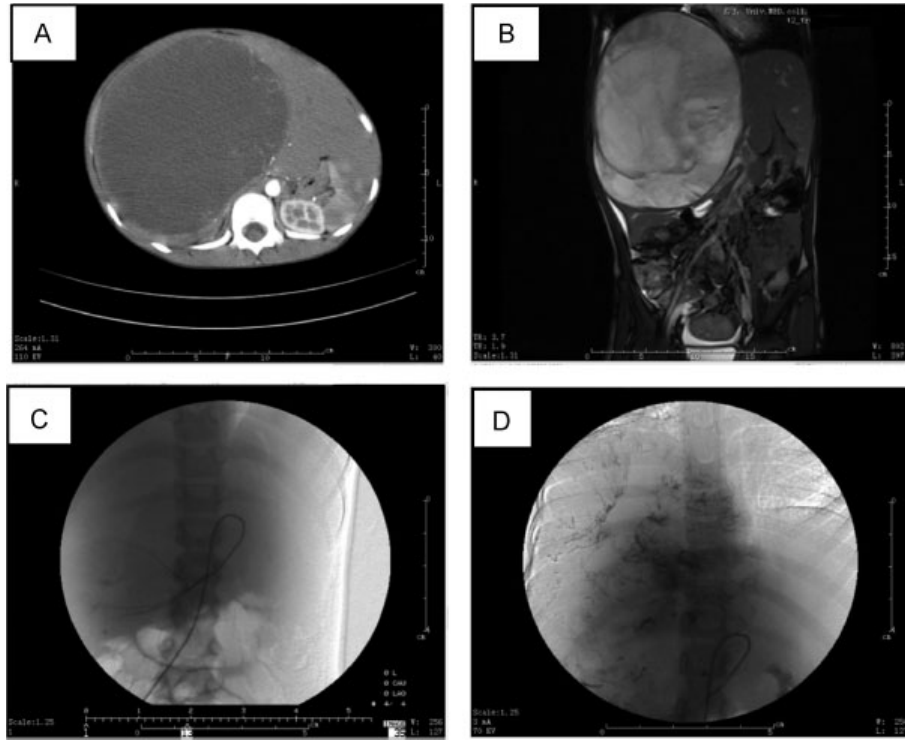
Fig. 1 (A and B) CT and MRI scans of case 1 show an unresectable mass in the liver. (C) Digital subtraction angiography displays the tumor ’ s blood supply of “ holding ball. ” (D) The feeding artery of the tumor was embolized. CT, computed tomography; MRI, magnetic resonance